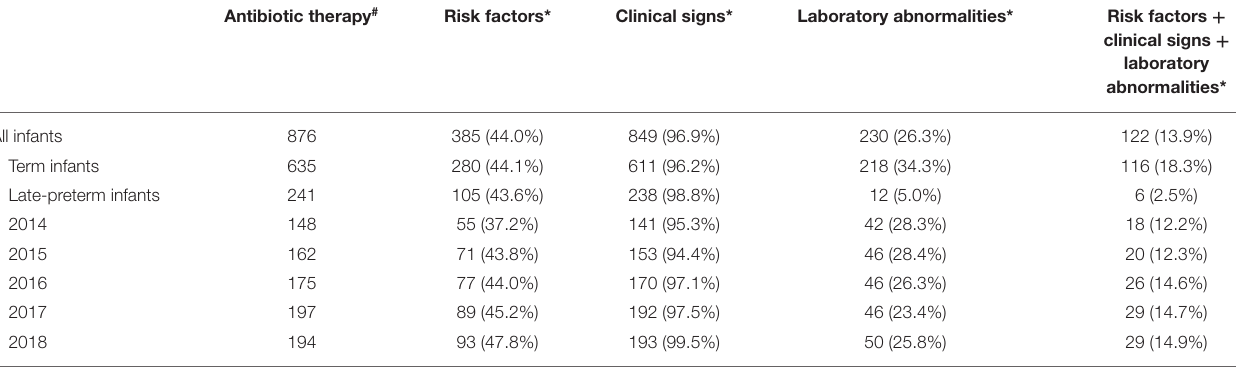
TABLE 2 | Characteristics of infants with antibiotic therapy for suspected early-onset sepsis.